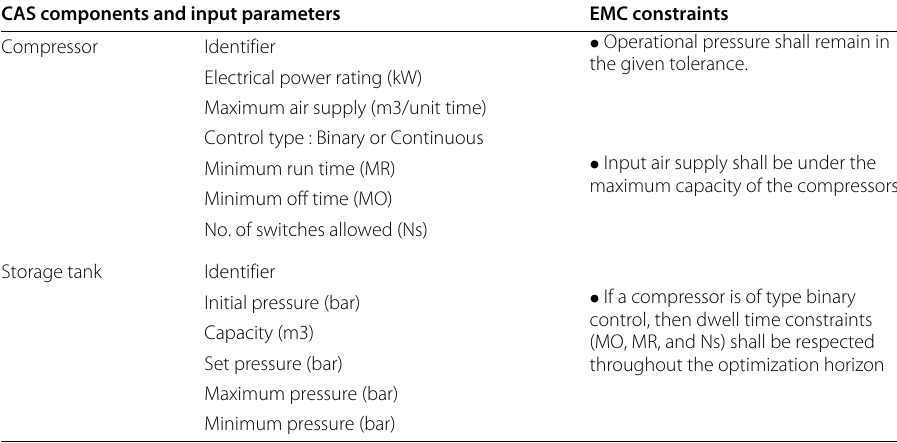
Table 2 Description of CAS and constraints in the model library CAS components and input parameters